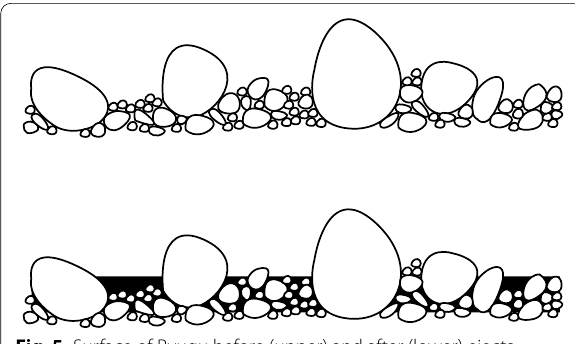
Fig. 5 Surface of Ryugu before (upper) and after (lower) ejecta deposition. When the surface is covered with ejecta, small-sized particles are obscured Fig. 4 Cumulative size–frequency distributions of particles inside the SCI crater (red curve) and outside the SCI crater (blue curve). The distribution of particles inside the crater is the sum of the distributions of particles in Regions 03 08, as shown in Fig. 3b. − The distribution of particles outside the crater is the sum of the distributions of 1.0R–3.0R shown in Fig. 2a. The slopes of the distribution of particles at sizes larger than 0.5 m and between 0.1 m and 0.5 m are 2.45 and 1.75, respectively − −